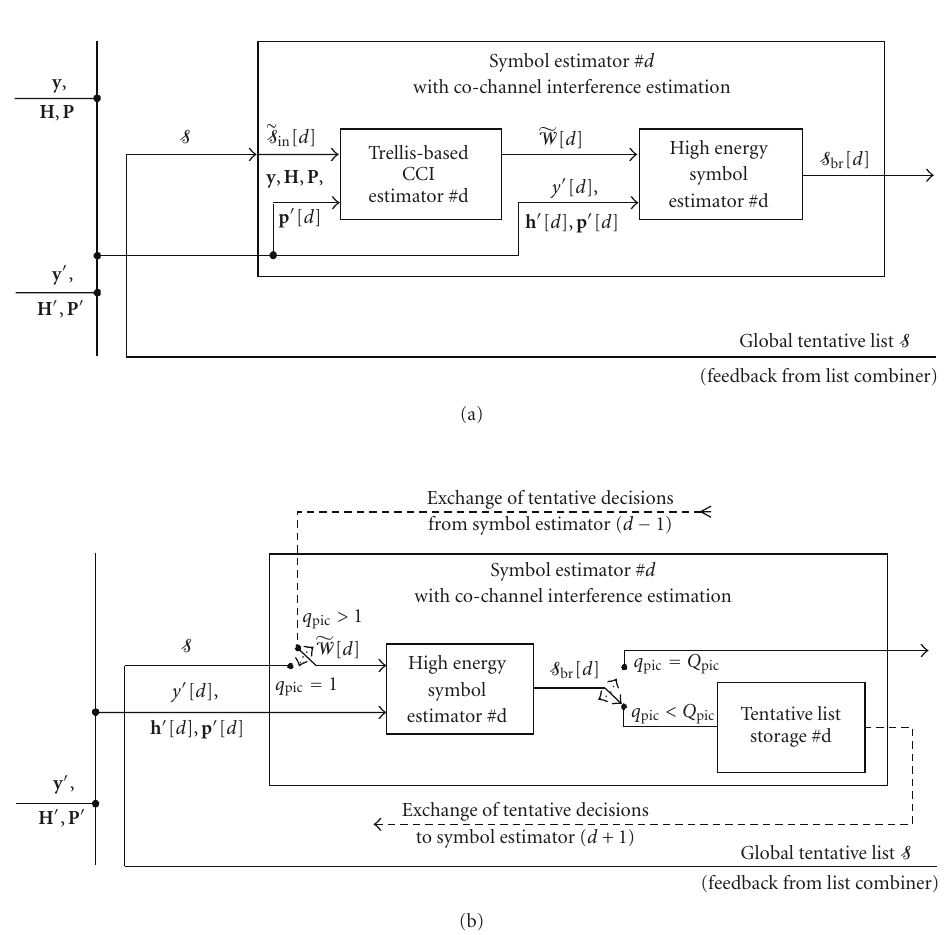
Figure 5: The d th symbol estimator in the PD-IE in Figure 4 using (a) explicit CCI estimation and (b) joint